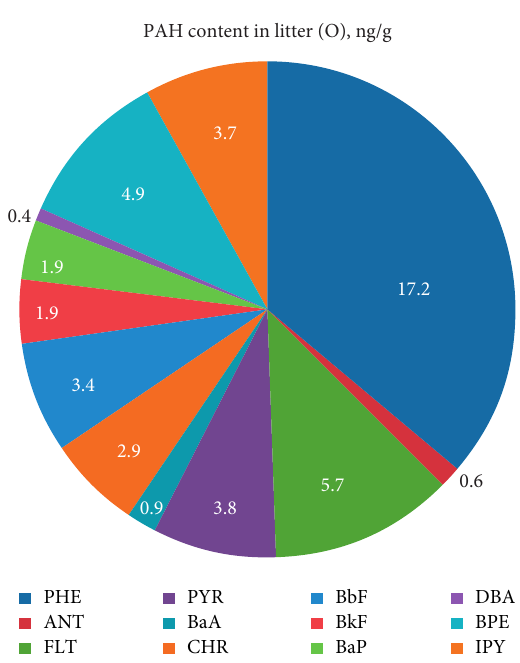
Figure 8: PAH component composition in control soil.